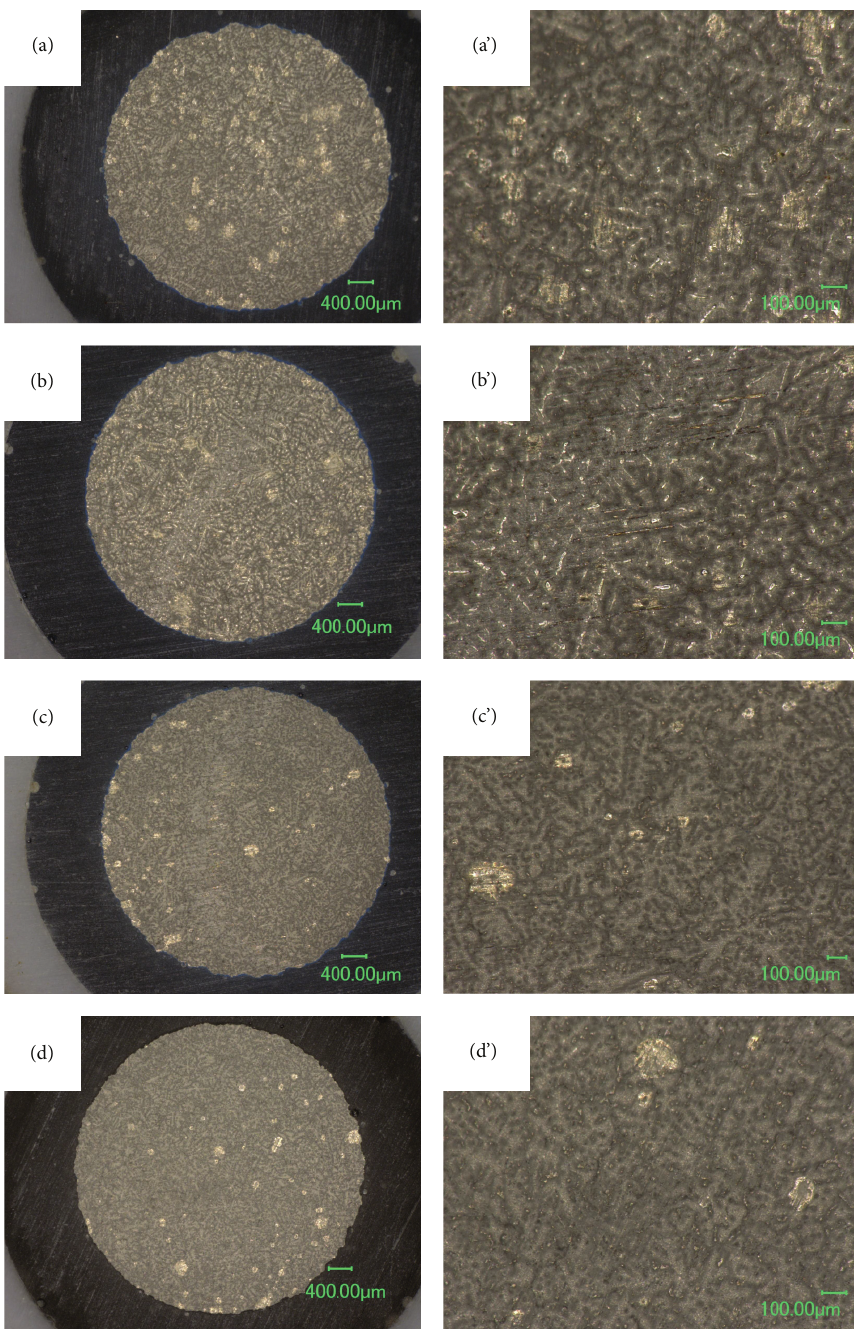
Figure 6: The surface morphologies of representative electrodes after FAC test for 4 h: (a) electrode 4, (b) electrode 10, (c) electrode 13, and (d) electrode